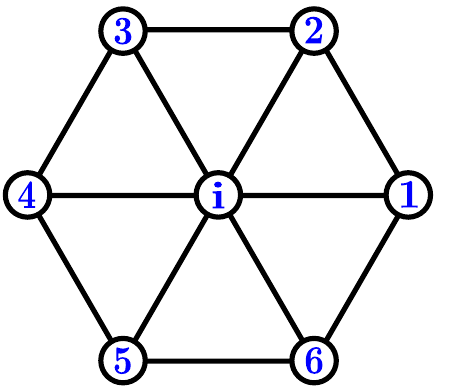
Figure 8. Schematic diagram showing locations of nn sites of a central site in the triangular